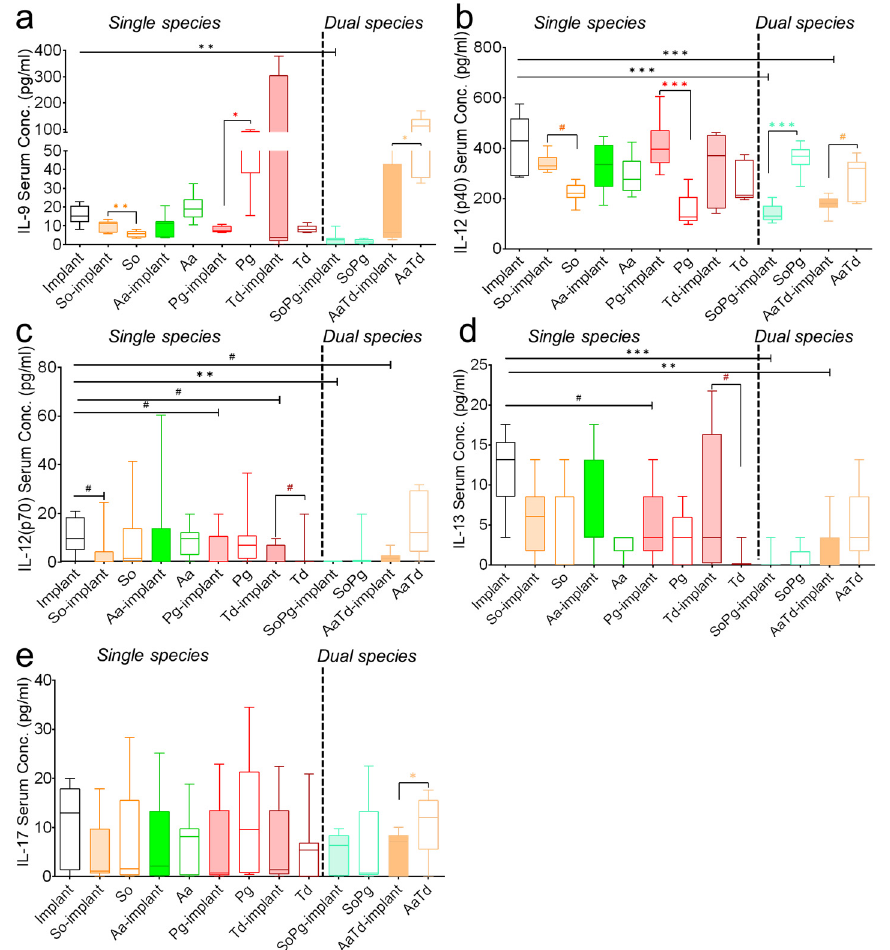
Figure 3. Modulations in the systemic expression of interleukins in mice. The box and whiskers graphs indicate serum interleukin expression for IL-9 ( a ), IL-12p40 ( b ), IL-12p70 ( c ), IL-13 ( d ), and IL-17 ( e ) in animals with sterile implants (empty bars), infected implants (filled colored bars), and infected tissues (empty bars with colored borders). Data were analyzed animal-wise (biological replicates ( n = 3), technical replicates (3 each)). Significant values have been adjusted by the Bonferroni correction for multiple tests. Symbols ***, **, *, and # indicate p < 0.001, p < 0.01, p < 0.05, and significant p -value prior to Bonferroni correction, respectively, between sterile and infected implants (black symbols). Significant differences between infections in the presence and absence of implants are indicated by colored symbols in each case. Abbreviations: So ( S. oralis ), Aa ( A. actinomycetemcomitans ), Pg ( P. gingivalis ), Td ( T. denticola